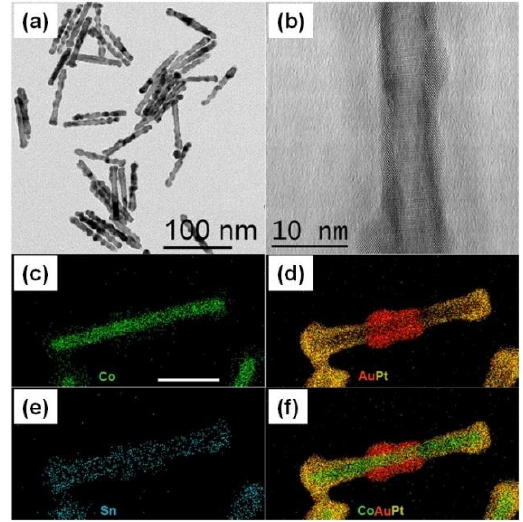
Figure 20. ( a ) TEM image of a Co core noble metal shell nanorod sample; ( b ) HRTEM image of a single nanorod, indicating a polycrystalline noble metal shell; ( c )–( f ) STEM- EDX elemental maps of a single nanorod to illustrate the location of the different shell elements (Co: green, Sn: blue, Au: red and Pt: yellow). The scale bar for the STEM-EDX maps is 20 nm. Reprinted with permission from [301]. Copyright 2015, American Chemical Society.